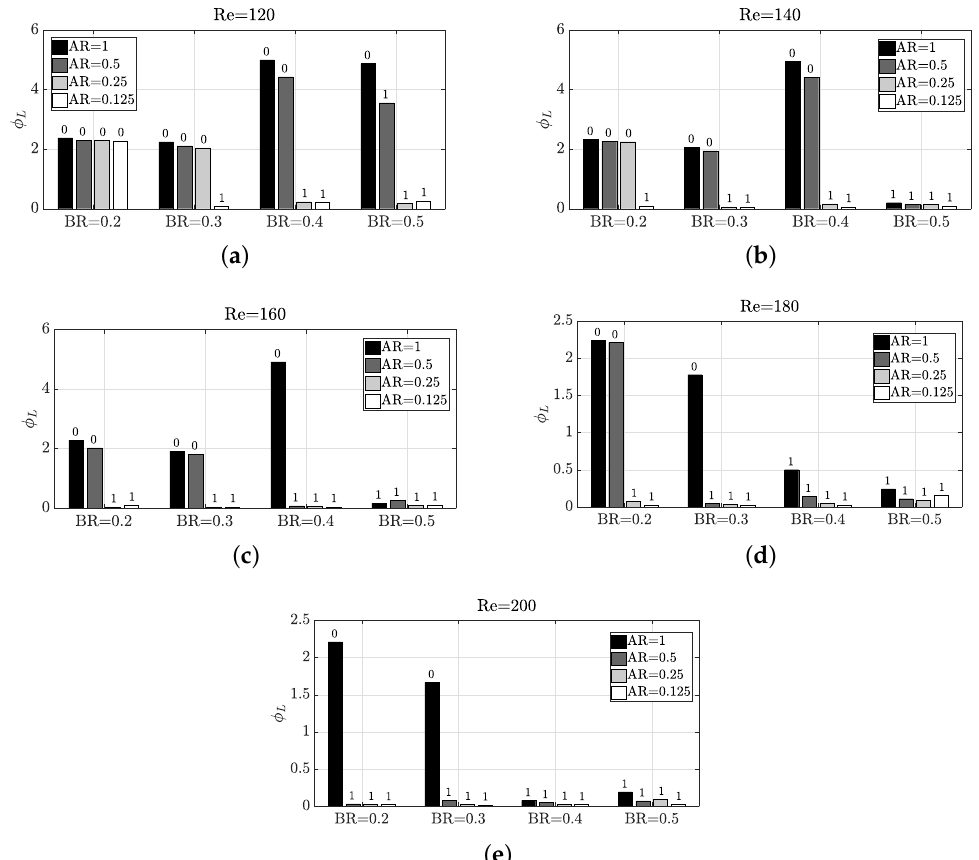
Figure 17. Impact of Reynolds number and geometry on φ L . The number on top of each bar indicates whether the configuration presents vortex shedding (1) or not